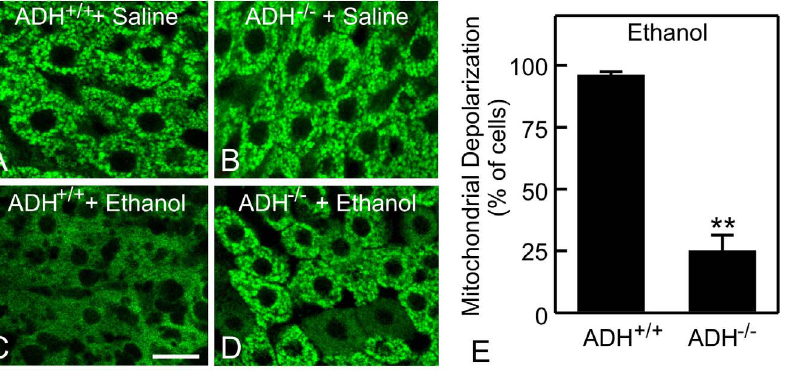
Figure 5. Role of alcohol dehydrogenase in ethanol-induced mitochondrial depolarization. ADH positive (ADH + / + ) and negative (ADH -/- ) deer mice were gavaged with saline ( A and B ) or ethanol (6 g/kg, C and D ). Rh123 fluorescence was detected after 6 h. Representative images of 4 mice per group are shown. Bar is 10 m m. E : quantification of cells with mitochondrial depolarization at 6 h after ethanol treatment. Values are means 6 SEM (n=4 per group). **, p , 0.01 vs ADH positive deer mice.